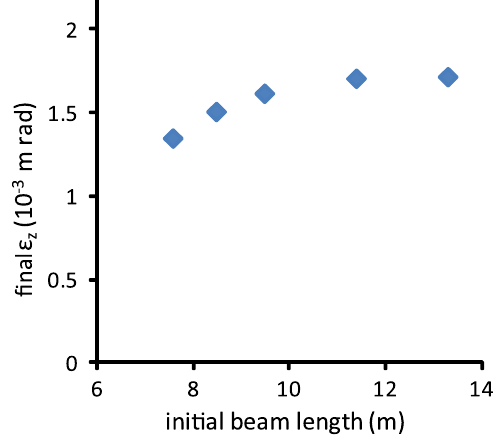
FIG. 12. Final z emittance at z ¼ 60 m ( (cid:1) 10 (cid:2) 3 ) vs initial edge-to-edge beam length, with fixed peak current, thus total charge scales proportionally with beam